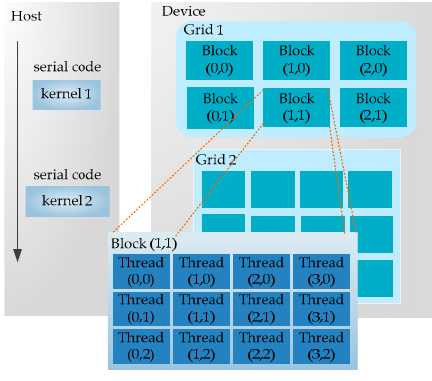
Figure 3. CUDA programming model.